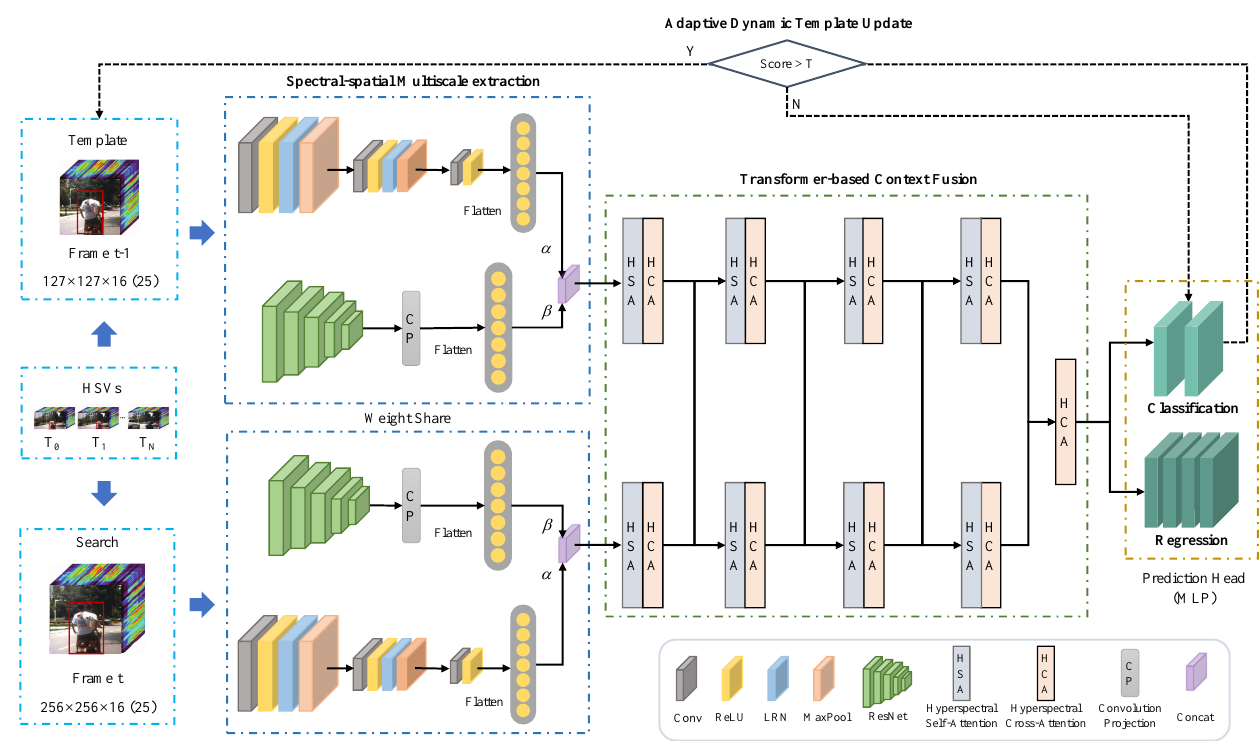
Figure 1. Illustration of the whole structure of the proposed hyperspectral video tracking, named SSTFT. The network extracts spectral–spatial multiscale features of the template and search region through the two branches. Specifically, these features interact with their own branches and are fused within the template and search branches using a transformer-based context fusion module to predict the bounding box and classification label. Finaly, the adaptive template update strategy is proposed to adapt the model to different challenges in